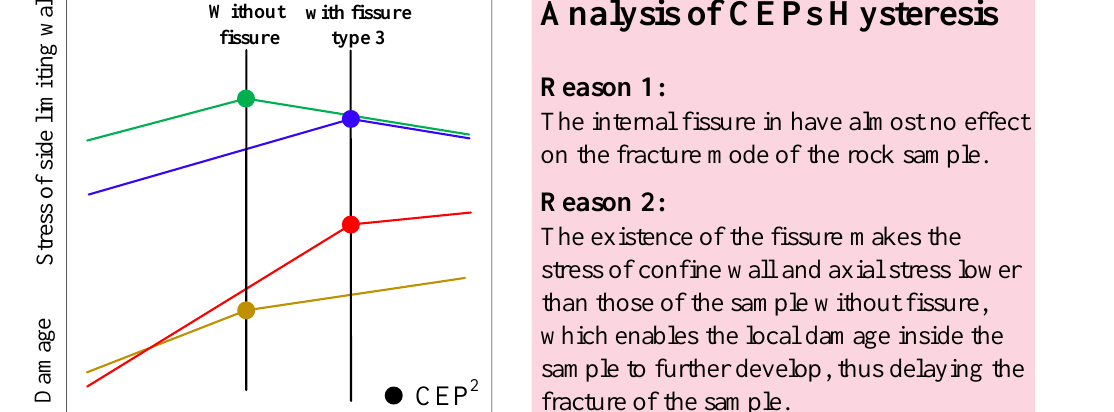
Figure 9. Analysis of the CEP hysteresis.